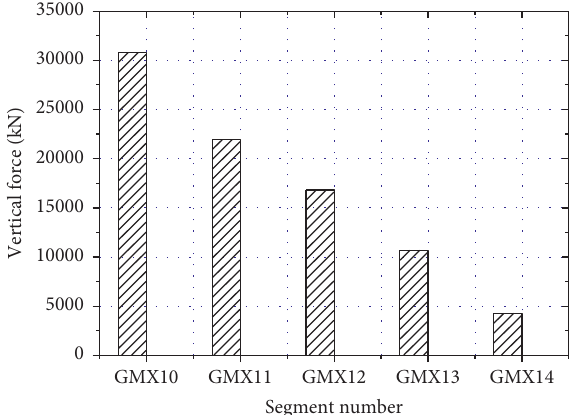
Figure 9: Vertical force transferred by each anchor